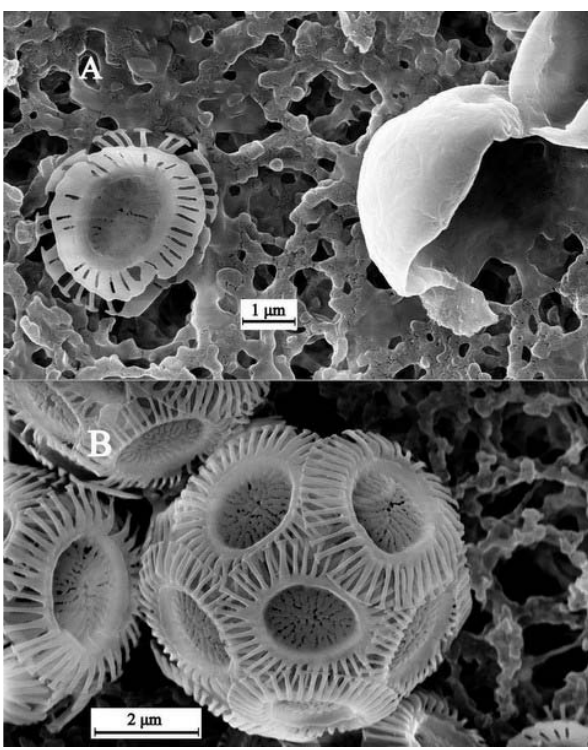
Fig. 1. Scanning electron microscope images of Emiliania huxleyi cells grown at: (A) 0.1mMCa 2 + and, (B) 10mMCa 2 + grown at 20 ◦ C and under PAR illumination of 150µmolm − 2 s − 1 .